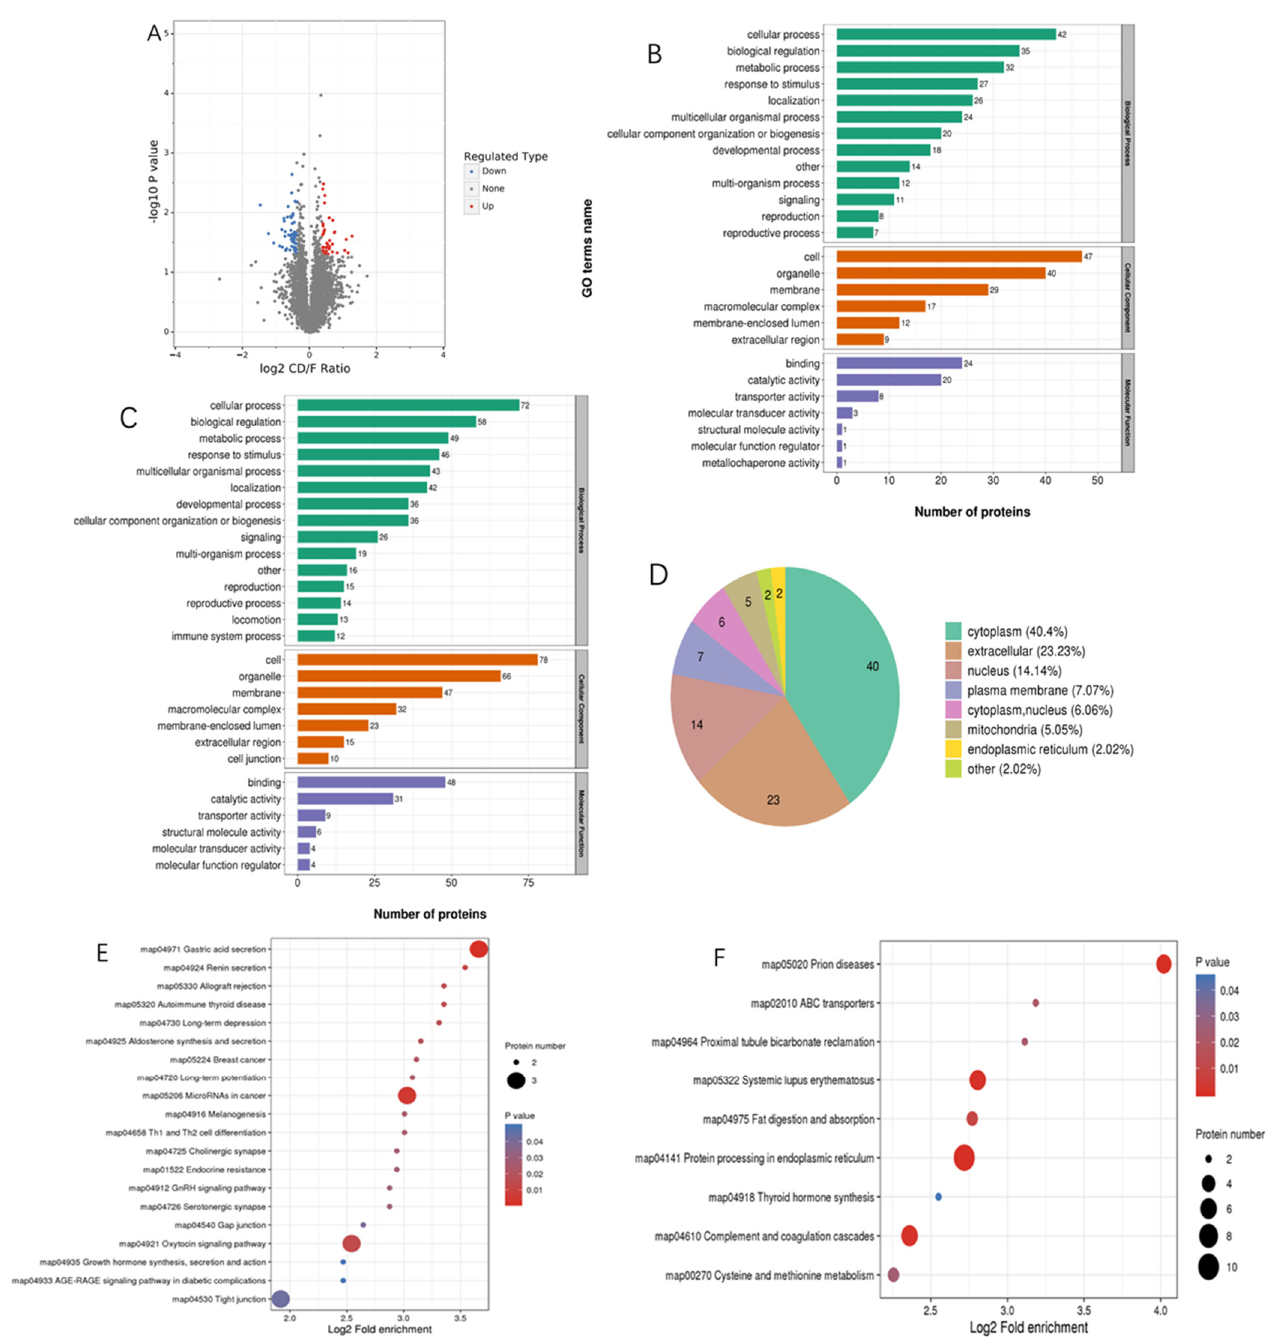
Figure 2. Significantly different expressions between MLD and Normal groups. ( A ) Protein significantly different expression between MLD and Normal groups (red means up ‐ regulated, blue means down ‐ regulated). ( B , C ) Differentially expressed proteins in GO functional classification ( B : up; C : down). ( D ) The subcellular localization of differentially expressed proteins. ( E , F ) KEGG enrichment pathways of different expressed proteins ( E : up ‐ regulated; F : down ‐ regulated).